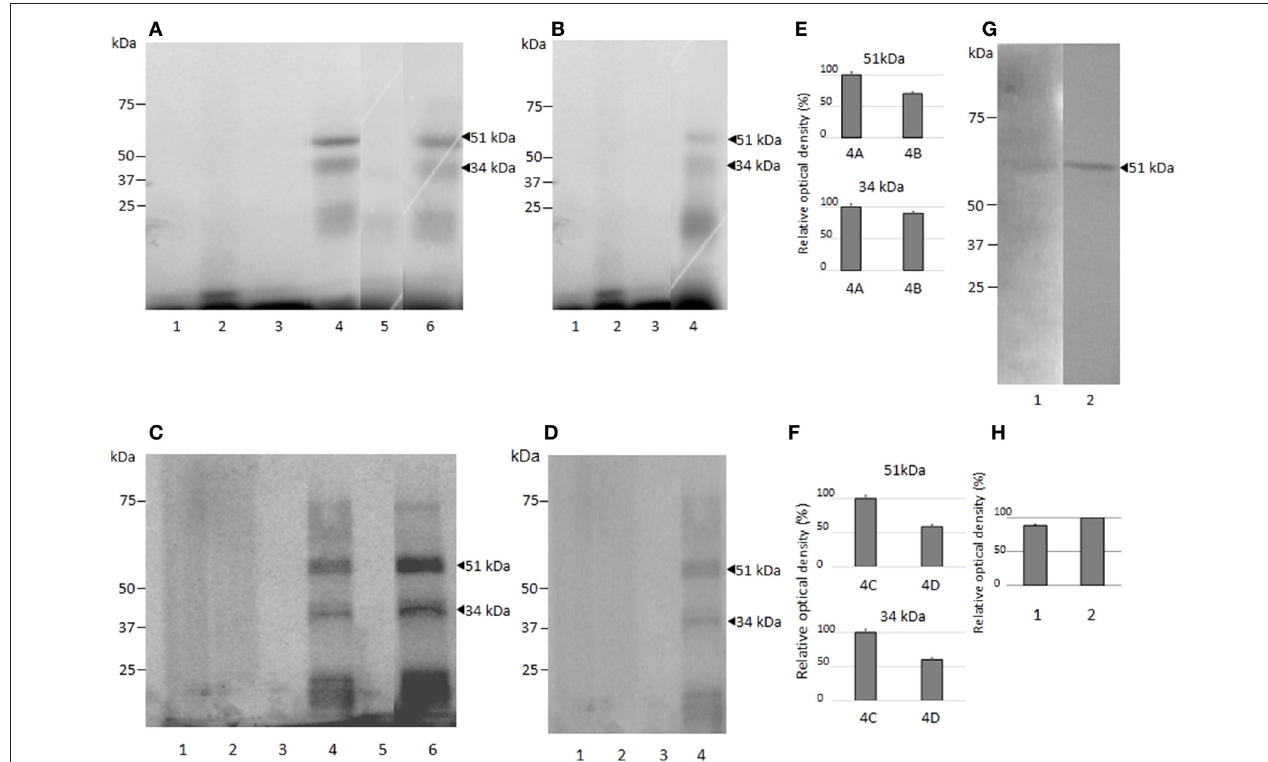
FIGURE 5 | Molecular weight of the nuclear proteins binding to the EhPgp5 HSE and their immunorelation to human HSF. UV-crosslinking analyses after EMSA in A and C2 clone grown in the presence (A,C) or in the absence (B,D) of emetine. One hundred micrograms of NE from clones A (A,B) and C2 (C,D) trophozoites were UV cross-linked to 5 ng of the γ 32 P-ATP radiolabeled HSE probe for 10min at 4 ◦ C, and DNA–protein complexes were electrophoresed through 15% SDS-PAGE, followed by exposure to X-ray film. Lane 1, UV untreated HSE probe; lane 2, UV irradiation of HSE probe; lane 3, UV untreated complete binding reaction; lane 4, UV treatment of complete binding reaction; lane 5, probe (150-fold molar excess); lane 6, unspecific competitor poly [d(I-C)]. Arrowheads, DNA–protein complexes after correction for the bound probe. Relative densitometry of each protein in clones A [8] and A (E) and C2 [20] and C2 (F) . (G) Western blot assay of UV cross-linked DNA–protein complexes of clones A [8] and C2 [20] using heterologous antibodies to anti-HSF1 from humans with their corresponding densitometric values. (H) Lane 1, clone A [8] ; and lane 2, clone C2 [20] . All assays were performed on three different